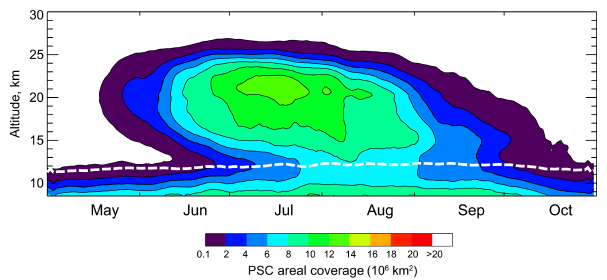
Figure 14. Twelve-year mean daily PSC areal coverage over the Antarctic. The climatological daily maximum MERRA-2 tropopause height is indicated by the dashed white